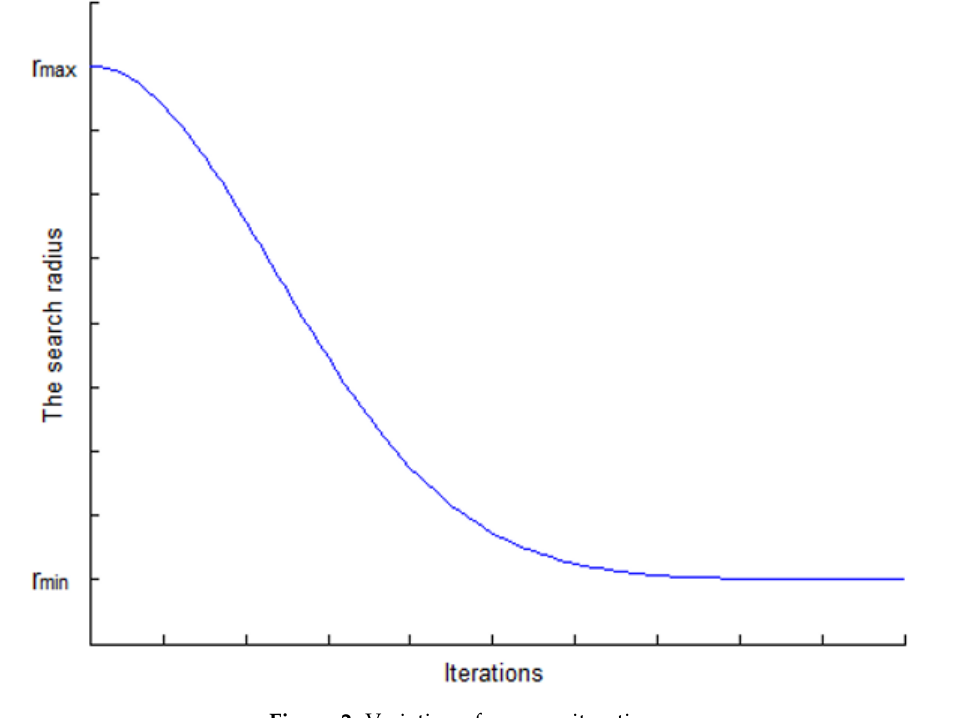
Figure 2. Variation of r versus iterations.